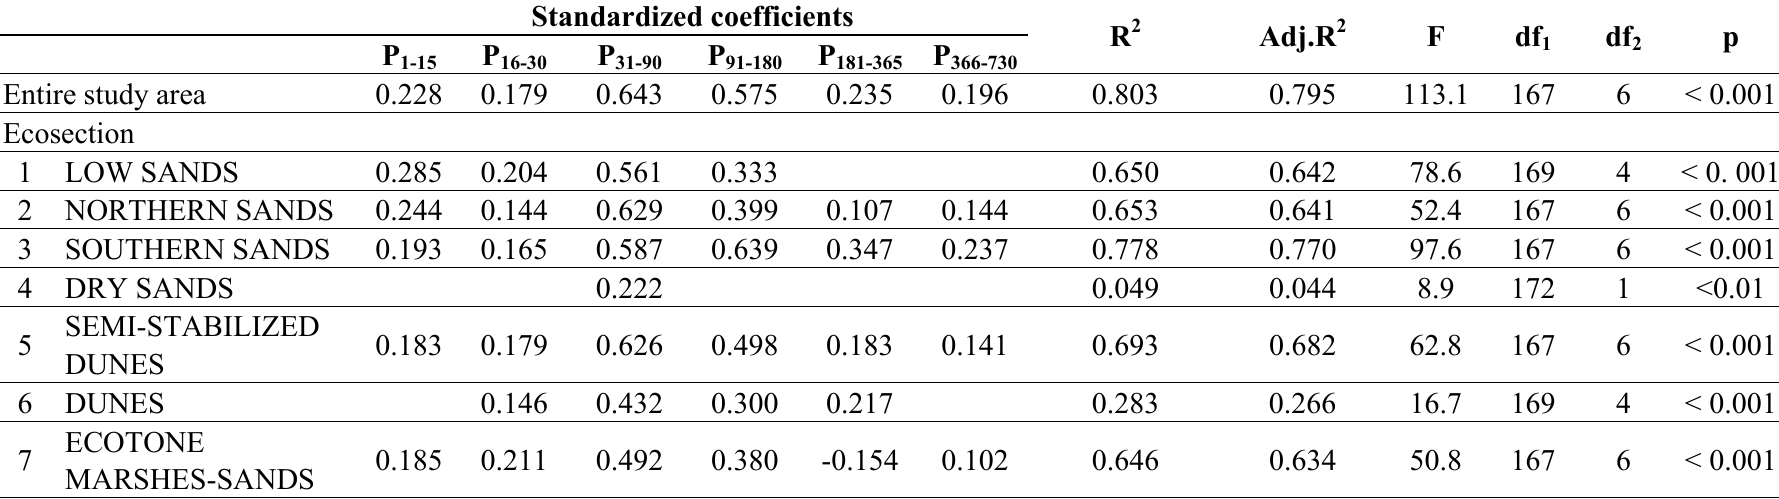
Table 5. Model results for predicting the flooded area from rainfall data. Models were conducted for the entire study area and for each ecosection. Predictor nomenclatures correspond to the number of days the accumulated rainfall was computed ( i.e. , P during the days 1 to 15 before the image